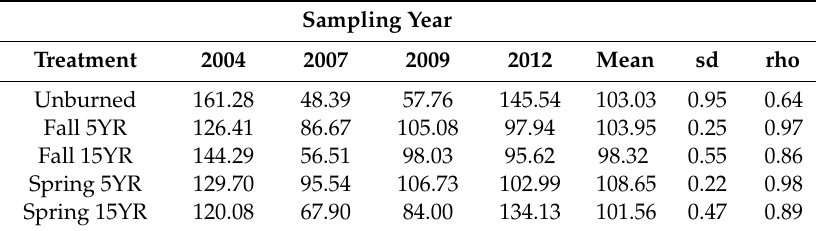
Table 2. Treatment-level angles of understory community trajectories.